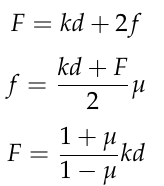
Figure 1. Schematic illustration of the linear friction damper (LFD): ( a ) general view of LFD; ( b ) internal details of LFD.